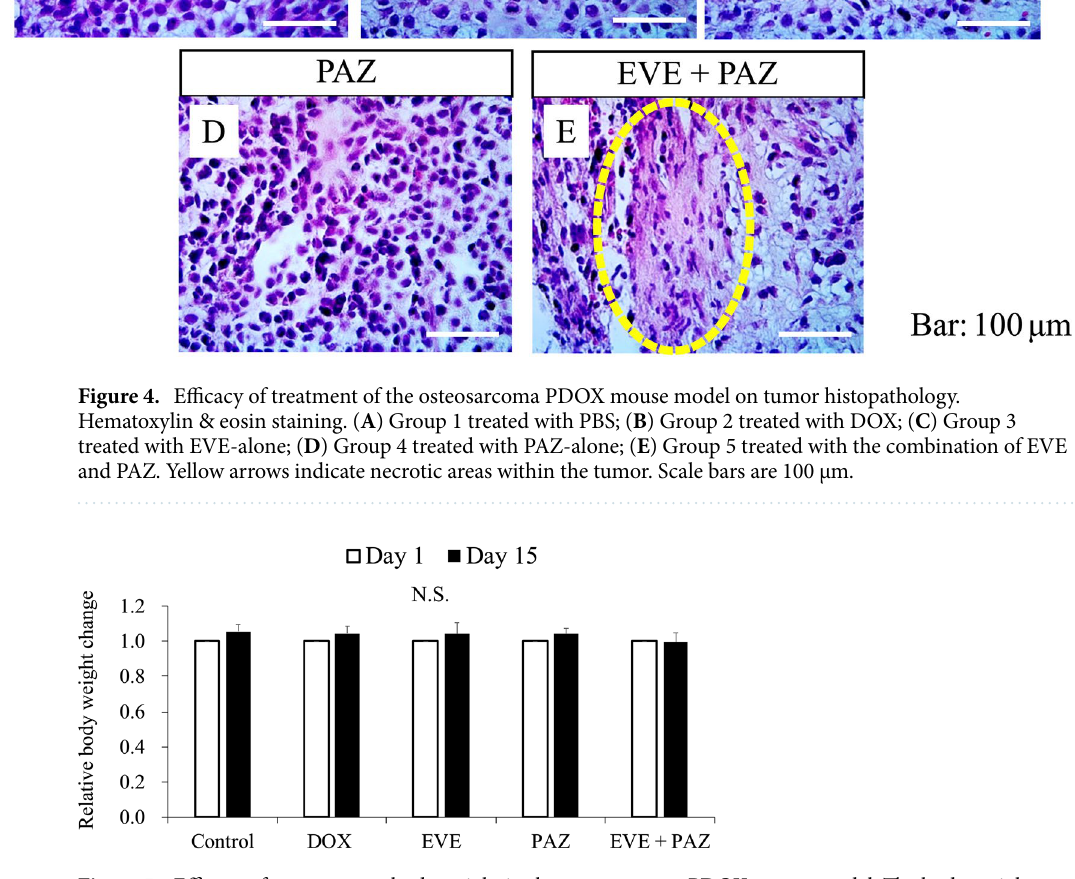
Figure 5. Efficacy of treatment on body weight in the osteosarcoma PDOX mouse model. The body-weight ratio of mice was calculated in each group on the 15th day from initial treatment relative to the body weight at the beginning of the experiment. Error bars show ± standard deviation. Statistical analysis was performed using the Tukey-Kramer